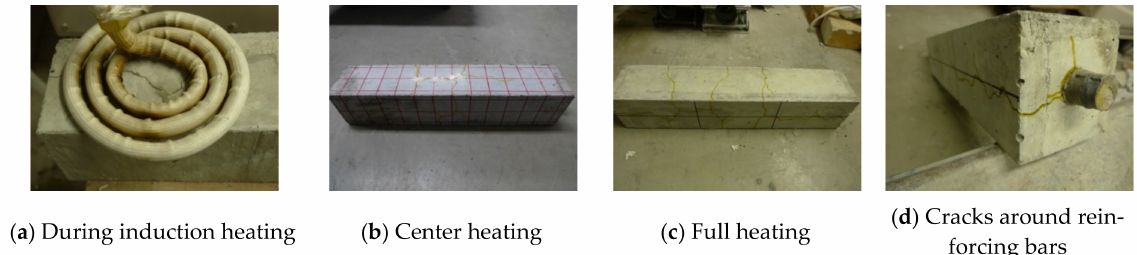
Figure 9. Cracks in single reinforced concrete due to induction